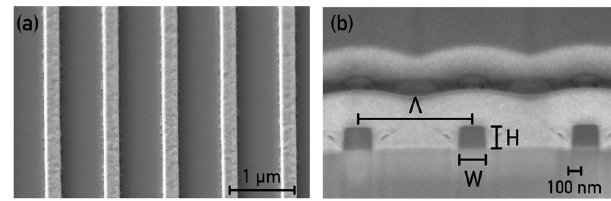
Fig. 3 Scanning electron microscope images of the fabricated silicon meta-mirror. a Top view, b side view. Λ is the period of the structure, W is the width, and H is the thickness.